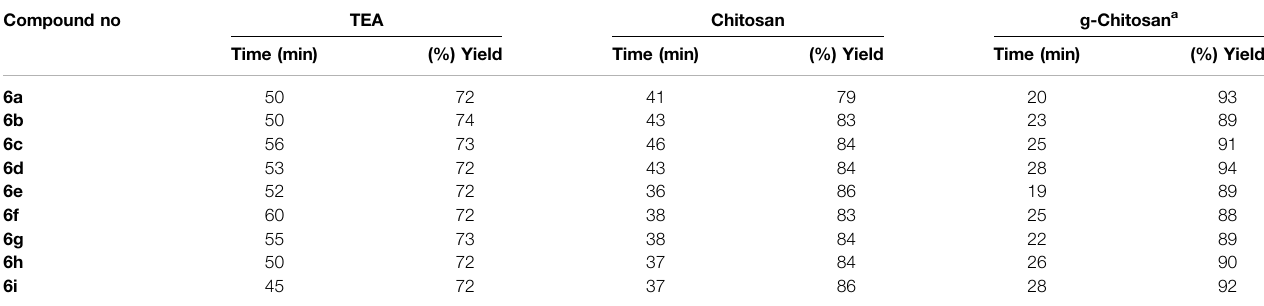
TABLE 1 | Comparison of synthesis of thiazolylcoumarines 6a – i under ultrasound irradiation using different basic catalysts on the time of reaction and the yield% of the products. Compound